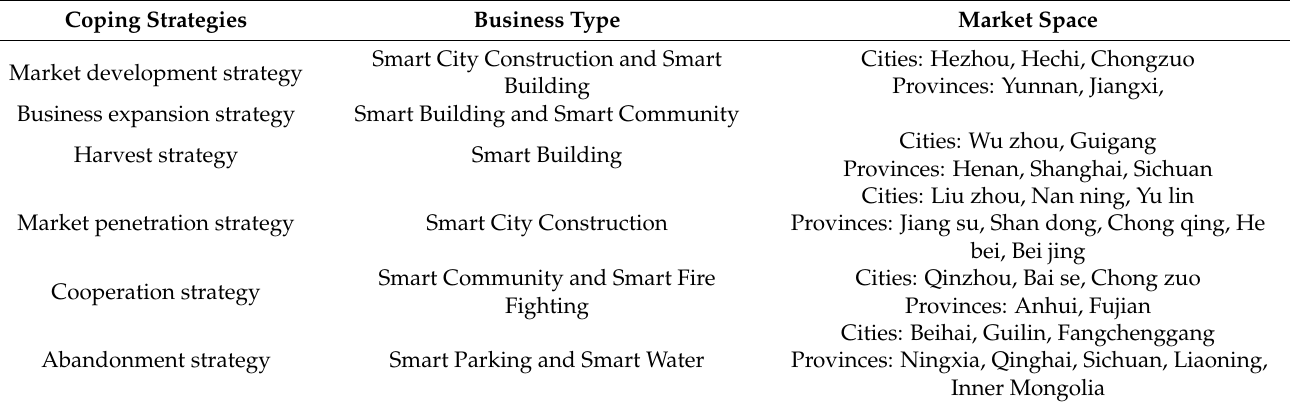
Table 5. Analysis on suggestion strategies of DK